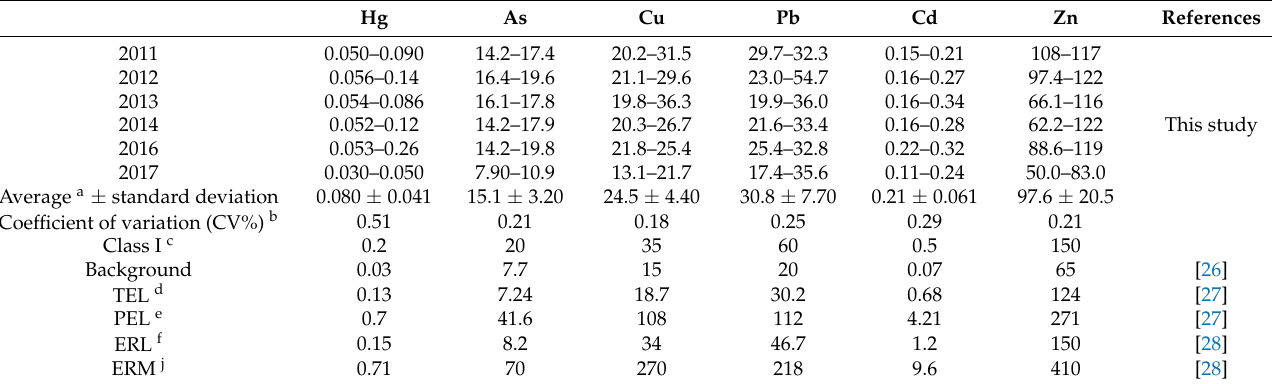
Table 1. The concentrations of HMs in the dumping area (unit: mg/kg). Hg As Cu Pb